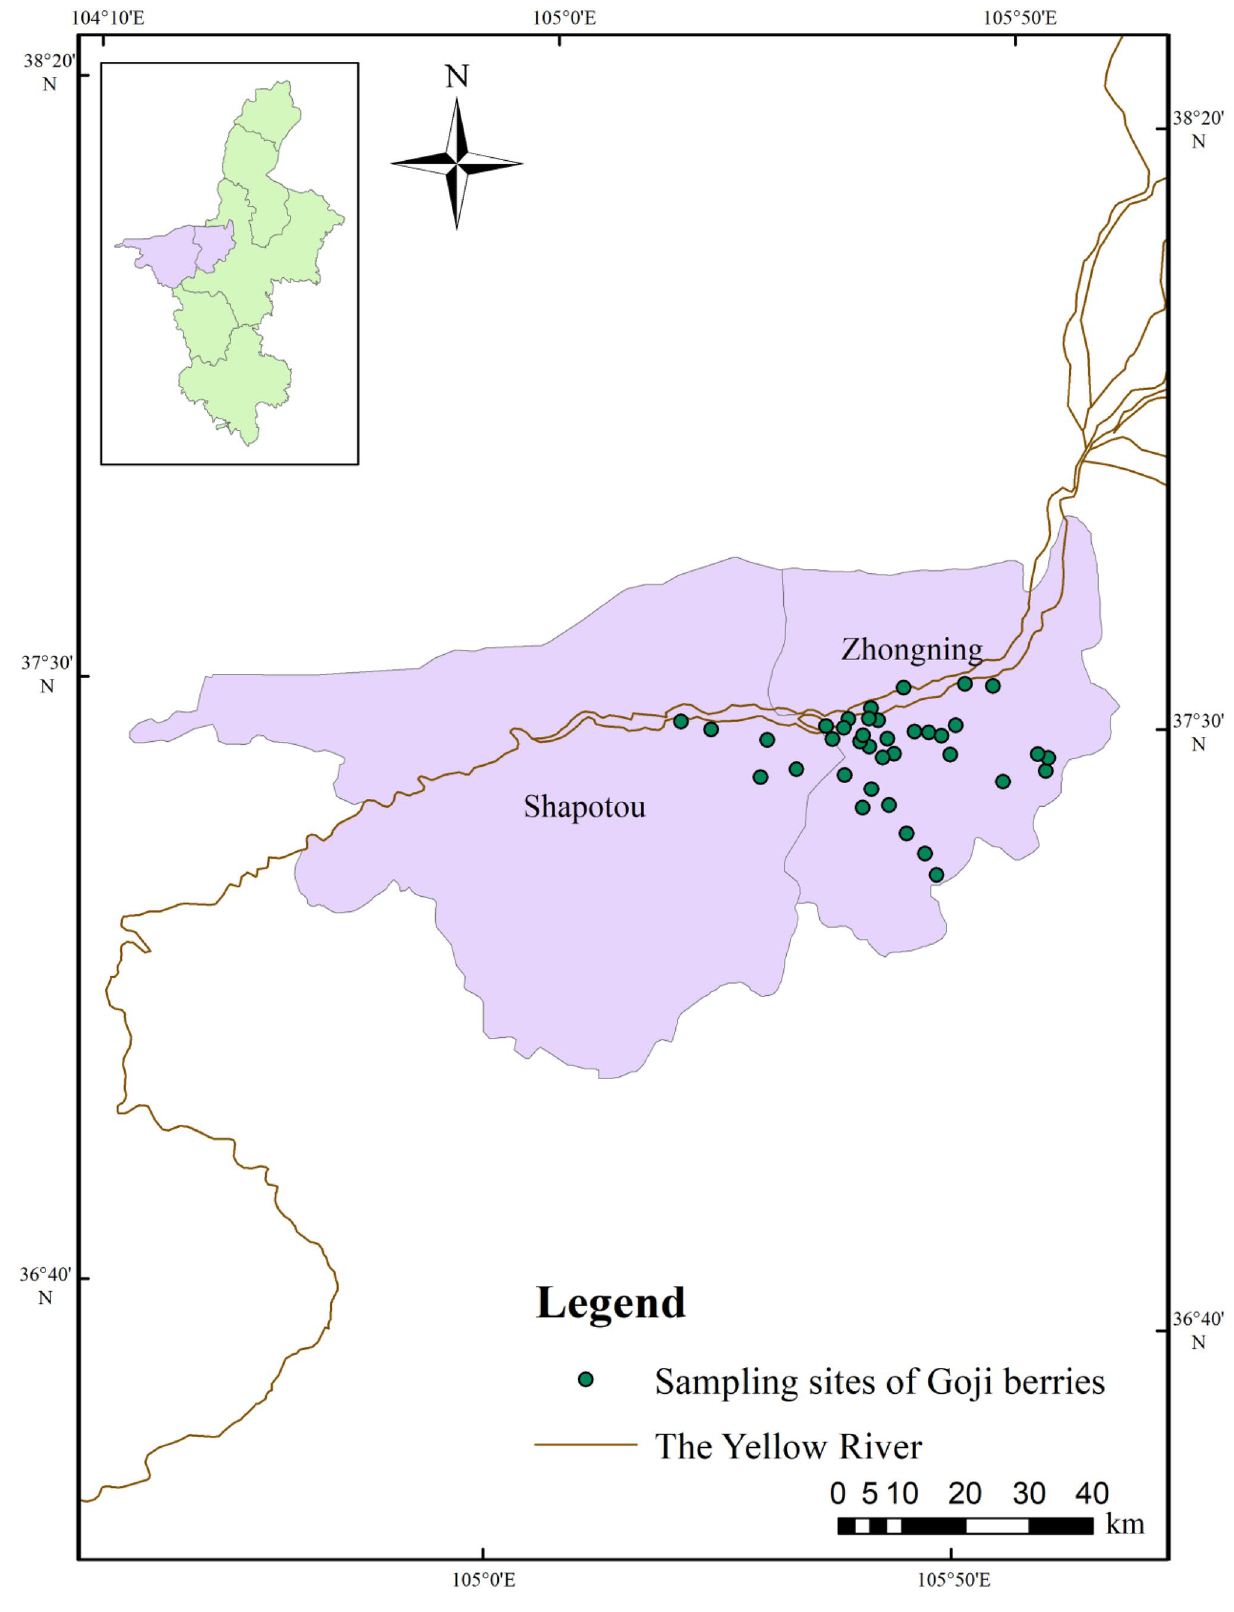
Figure 1. Sampling sites of Goji berries from plantations in genuine producing area (represents sampling sites) (data source: http:// bbs. 3s001. com/ forum. php? mod= viewt hread & tid= 13374 1& page=1# pid29